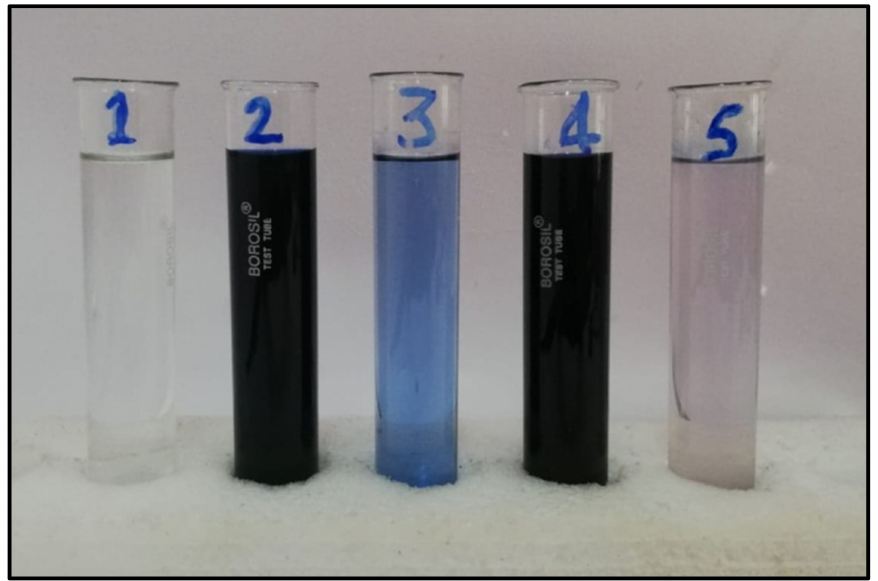
Figure 15. (1) Distilled water; (2) DB15 dye in distilled water; (3) TIE; (4) DB15 dye in TIE; (5) Filtrate after adsorption of dye on HNT after 15